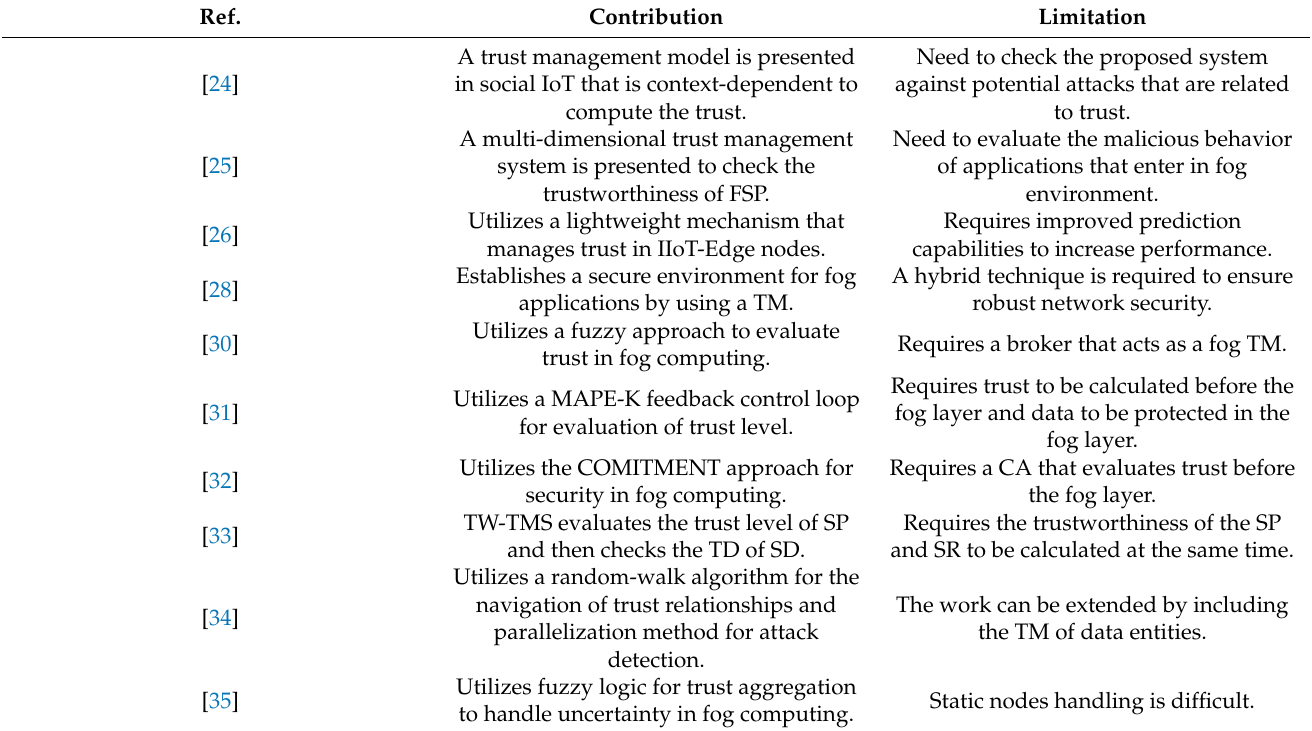
Table 1. Comparative Analysis of Existing